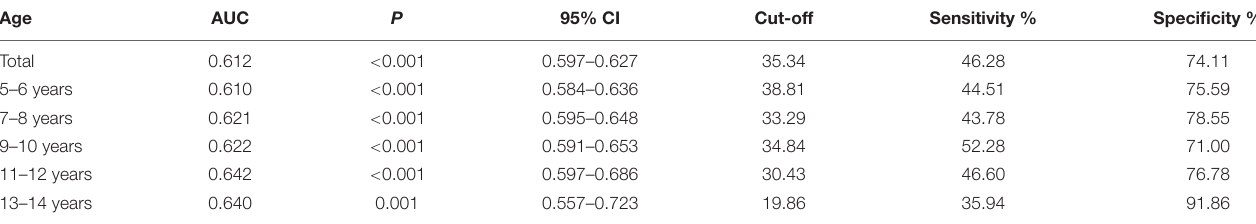
TABLE 2 | Receiver operating characteristic curve analysis of 25-hydroxyvitamin D levels in different age samples of two groups.